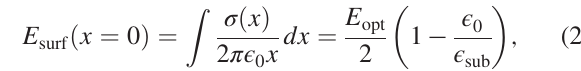
FIG. 5 (color online). (a) A schematic of the model for giant CD as explained in the text. (b) Black curves show CD spectra taken at θ ¼ þ 45 ∘ . The excitation powers range from 9 mW to 28 mW during wavelength tuning. Red curves show PL excitation spectra taken under a perpendicularly polarized excitation at normal incidence. Top, middle, and bottom panels correspond to a 2.5- μ m-long (9, 7) tube, a 3.0- μ m-long (10, 5) tube, and a 2.4- μ m-long (10, 6) tube, respectively. The excitation spectra are normalized to powers of 170, 40, and 110 μ W for the (9, 7), (10, 5), and (10, 6) tubes, respectively. The peaks are assigned according to Ref.